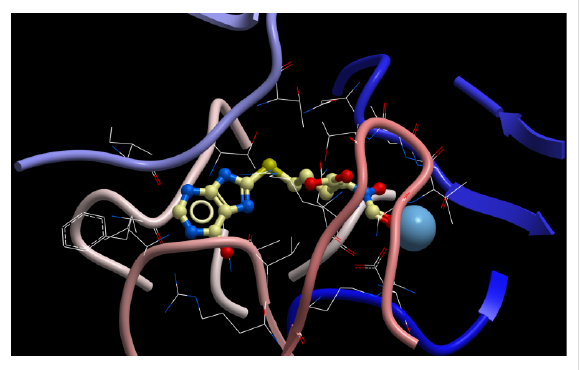
Figure 1: Structure of AdSS catalytic domain from Mg center (light blue) to IMP loop (tan) with compound 13